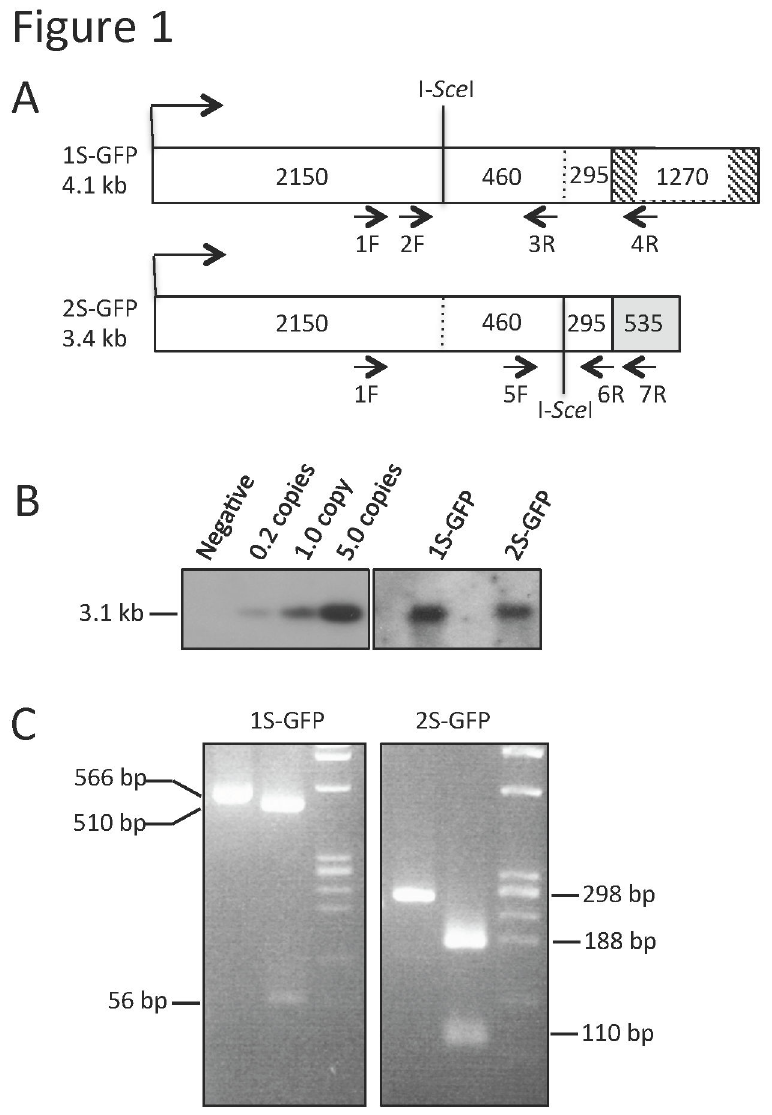
Figure 1. Structure and confirmation of the 1S and 2S GFP transgenes. ( A ) For each construct schematic, the numbers of bases are indicated to show the lengths of homology between the two as well as the relative positions of the engineered I- Sce I restriction sites. The 3’UTR sequences of the two constructs do not share homology and are indicated as a hatched box of 1270 bp for 1S-GFP and a grey box of 535 bp for 2S-GFP; these non-homologous sequences allow for PCR amplification specific to each transgene. Nested PCR primer pairs used for verification of intact construct sequences and for analysis of GFP+ hematopoietic colonies are indicated. Primers 1F-4R followed by 2F-3R amplify sequence flanking the I- Sce I site in 1S-GFP. Primers 1F-7R followed by 5F-6R amplify sequence flanking the I- Sce I site in 2S-GFP. ( B ) Southern blotting to estimate copy number utilized a GFP ORF DNA fragment of 3.1 kb and diluted to pg amounts that approximated 0, 0.2, 1.0, and 5.0 copies per genome spiked into 10µg non-transgenic mouse DNA. Genomic DNA from single transgenic mice (either 1S-GFP or 2S-GFP) was digested with restriction endonucleases within the GFP promoter and ORF of both transgenes to yield a 3.1 kb fragment. Band intensities are consistent with 4-5 copies of 1S-GFP and 2-4 copies of 2S-GFP, and were confirmed with Q-PCR data on the same samples (data not shown). ( C ) PCR reactions flanking each DSB site in the two GFP constructs confirm intact I-SceI recognition sites. Nested PCR as described in Materials amplified each transgene shown in the left side lane of each image. Digestion with I- Sce I endonuclease produced the expected sizes indicated in the middle lane of each image. Right side Marker lane PhiX.